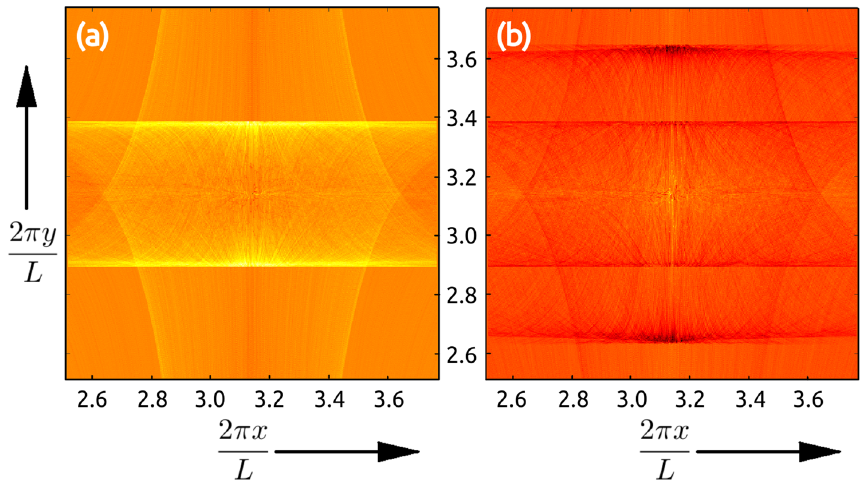
Figure 2. The highest singular DMD eigenvector, D ( 1 ) , obtained for: (a) St = 1.0 mono-disperse system, (b) a bi-disperse mixture of St = { 1, 2 } with 7:3 ratio of initial particle concentrations. The horizontal lines correspond to the caustic wavefronts, and the number of such fronts indicate the different Stokes number particles. Also notice that the wavefronts corresponding to St = 1.0 appear around the same values of y in both (a,b) , indicating that the positions of DMD wavefronts are not perturbed by the presence of particles with different Stokes numbers. The figures were created using Matlab 2020a, https:// www. mathw orks. com/ produ cts/ matlab. html.